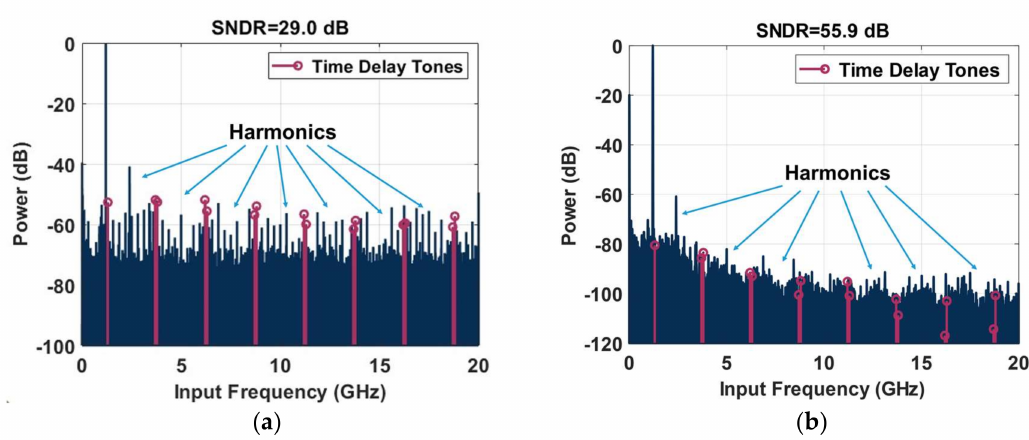
Figure 5. ( a ) The spectrum before calibration; ( b ) the spectrum after calibration.